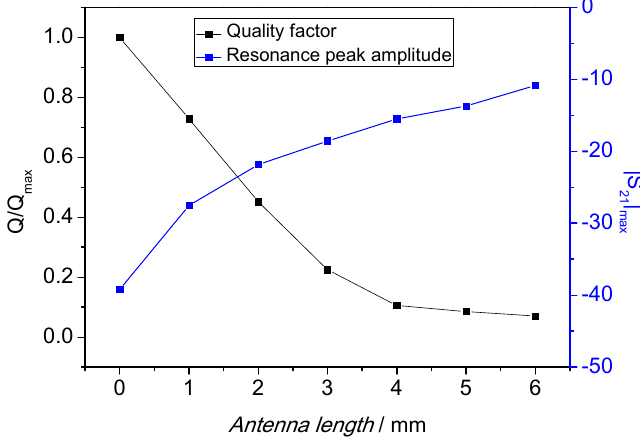
Figure 3. Quality factor and peak amplitude as a function of the antennas length ( l ). In the final design two 0.5-mm long antennas have been fabricated as a compromise between these two quan- tities.